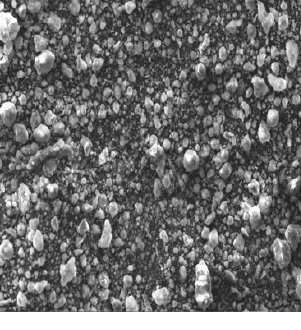
Figure 18. SEM images of AAC specimens: ( a ) CAAC-C, ( b ) CAAC-F, ( c ) GGBS-CE-AAC-F.